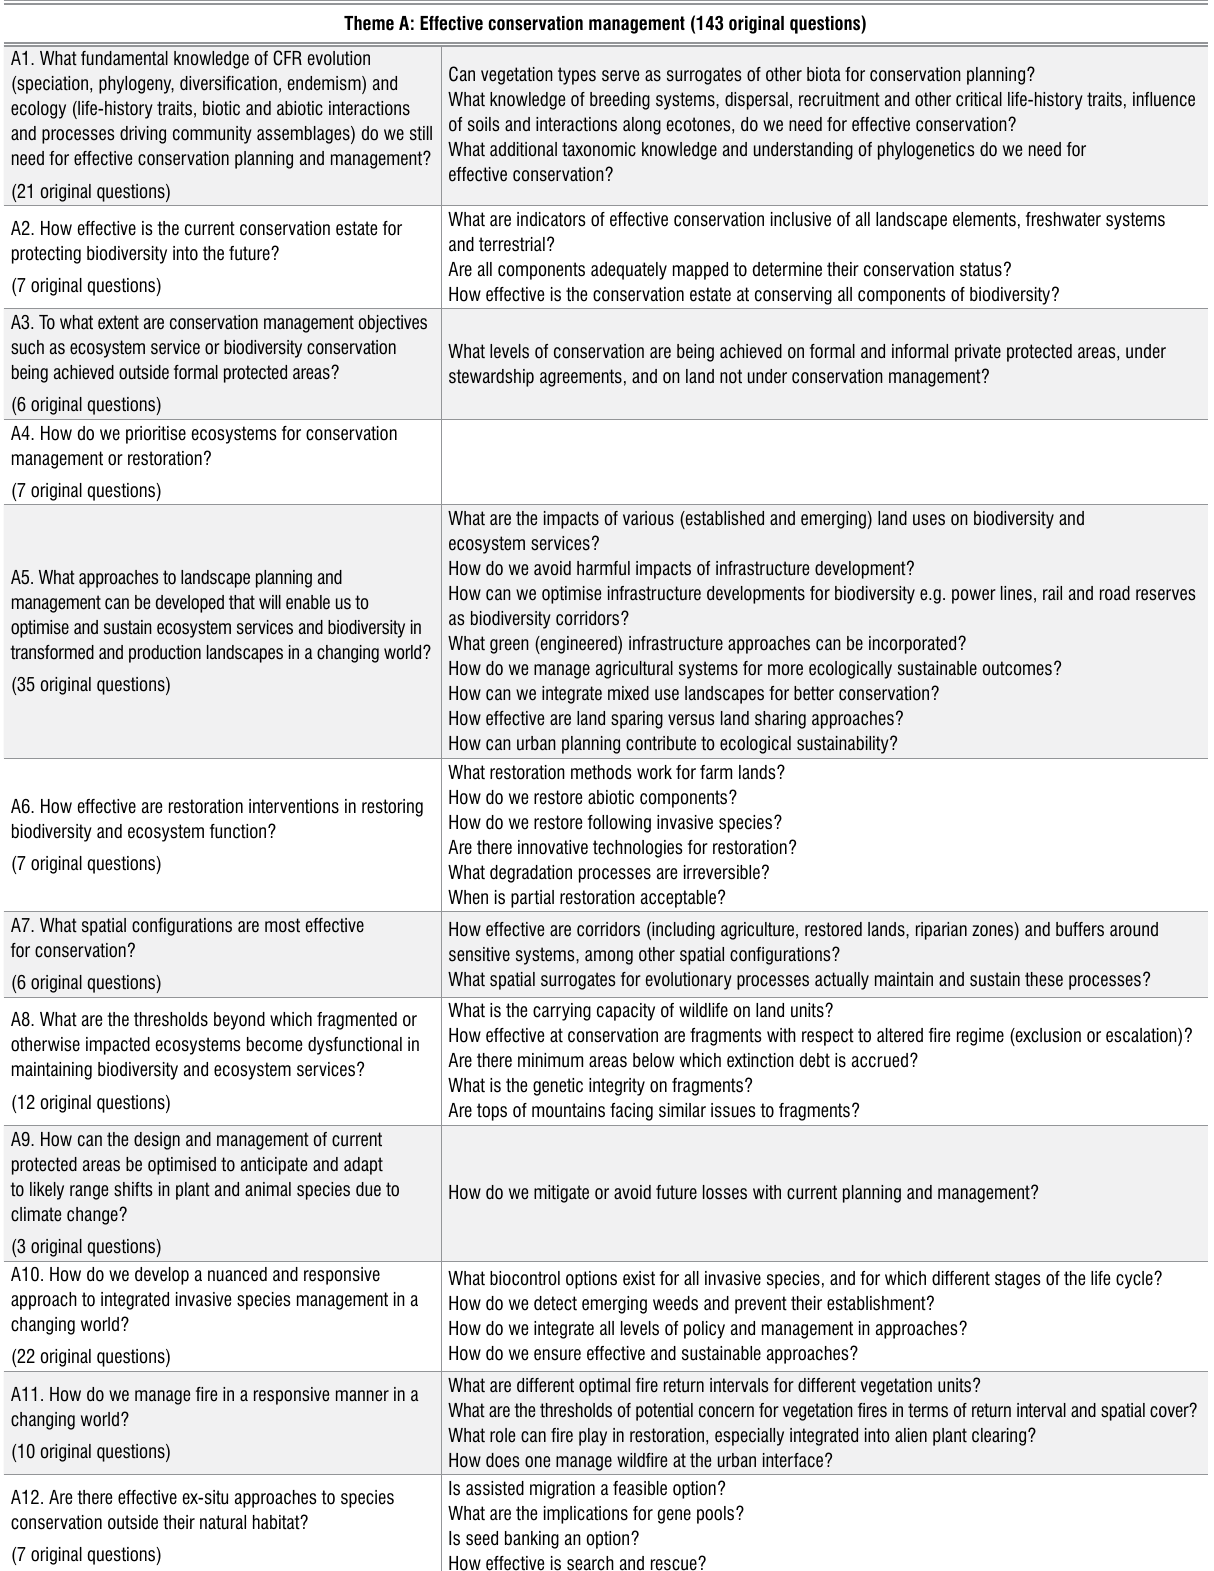
Table 1: Research questions were arrived at through an inductive analysis of 361 questions submitted by members of the broader Cape Floristic Region (CFR) conservation community (Data set 3 10 ). Main questions are organised under themes and further clarification is provided in the right-hand column where relevant. The number of original questions from respondents contributing to a theme or research question is indicated in brackets. Theme A: Effective conservation management (143 original